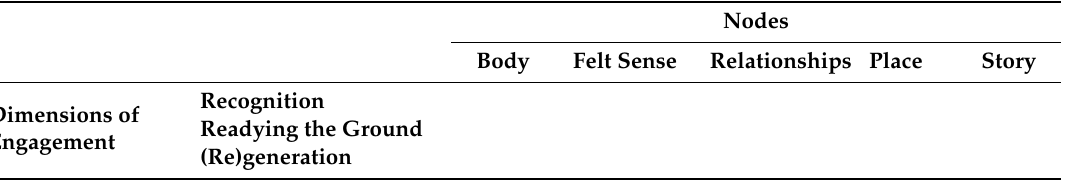
Table 1. Basic elements of the Healing is Rhizomatic conceptual framework.